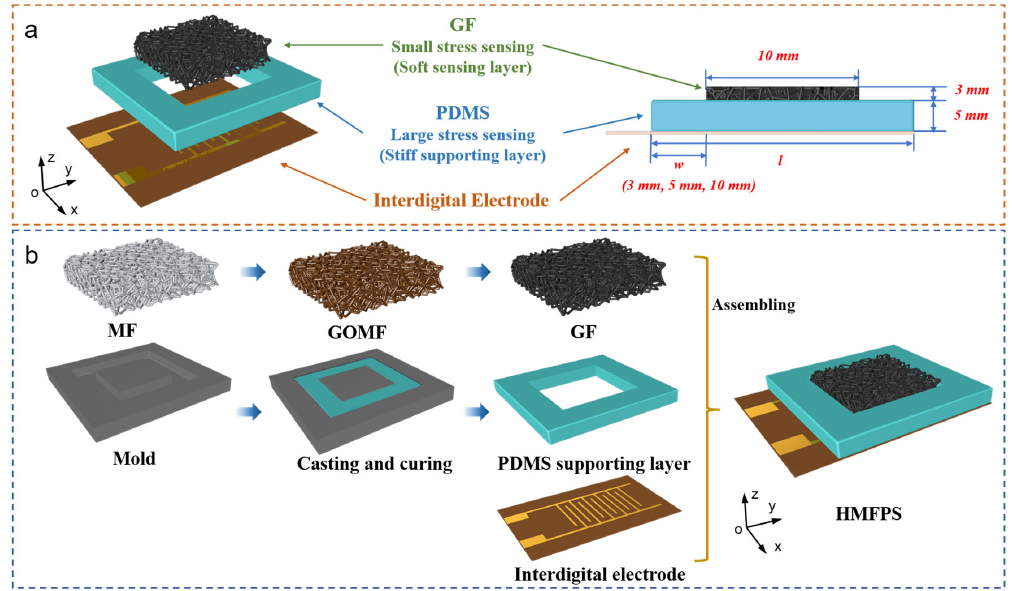
Figure 1. ( a ) Schematic of the HMFPS; ( b ) Schematic of the fabrication process of the HMFPS.